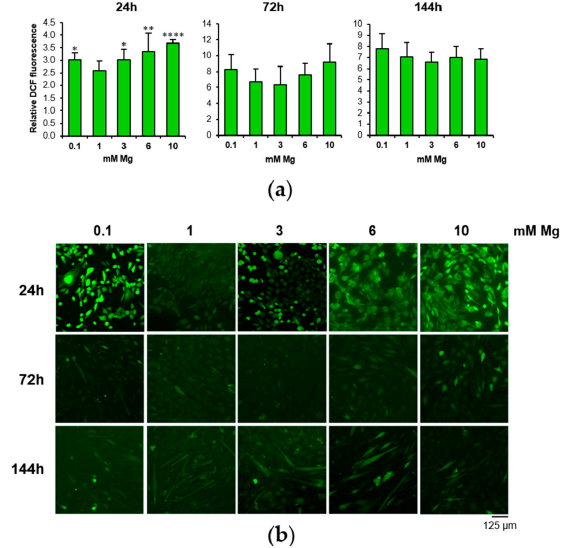
Figure 2. Low and high Mg induce ROS during myogenesis. After 24, 72 and 144 h of culture in DM in the presence of different extracellular concentrations of Mg, ROS accumulation was measured by 2 (cid:48) ,7 (cid:48) –dichlorofluorescein (DCF) assay. Fluorescence was normalized to the cell number ( a ). Images of DCF fluorescence emission were acquired on living cells (10 × magnification) ( b ). * Indicates